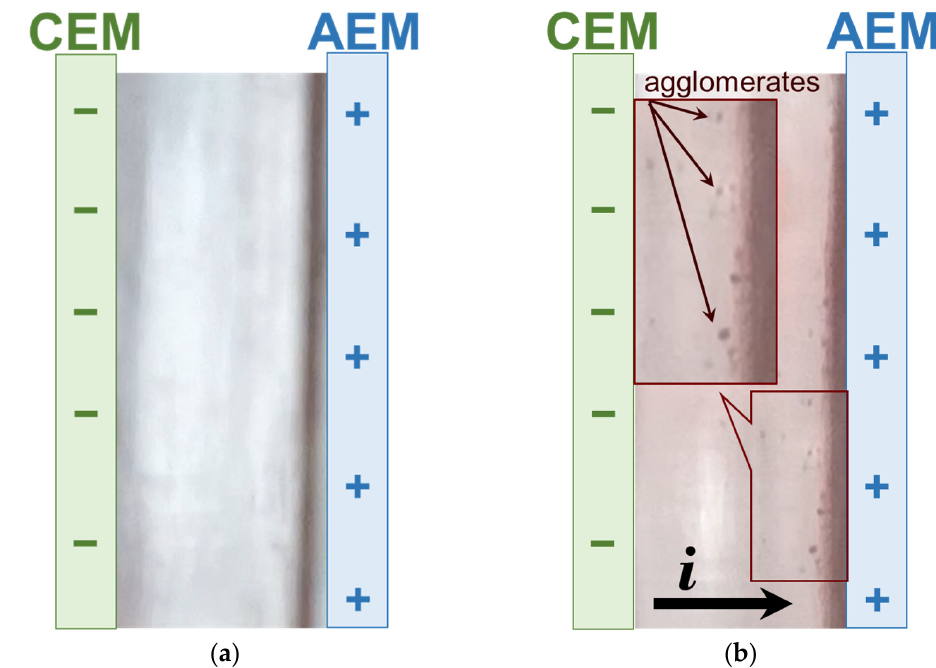
Figure 12. Frames from the video corresponding to the 10th minute of cleaning in operando without ( a ) and with ( b ) the use of an electric field ( i = 1.22 mA/cm 2 ). Cleaning was carried out after ED processing of model solution 4.